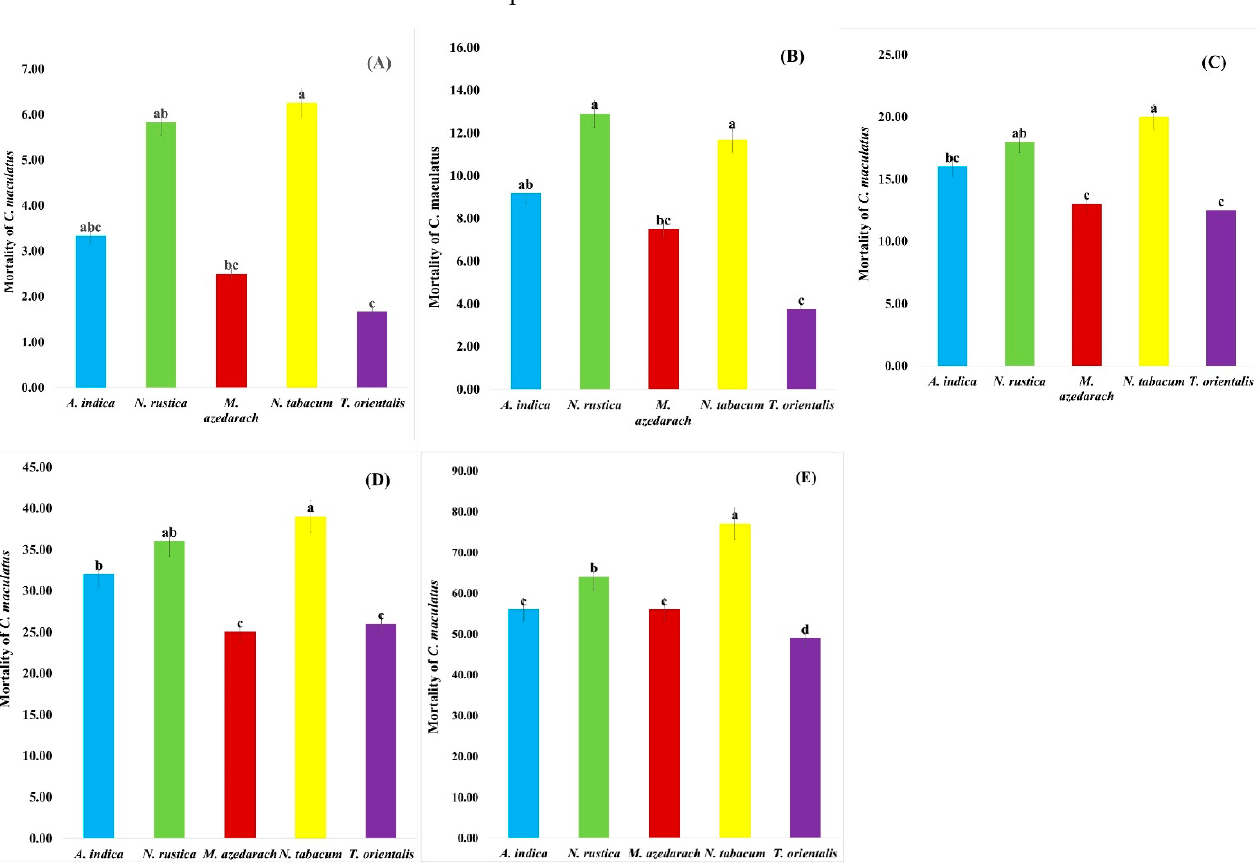
Figure 1. Mean percent Mortality of C. maculatus treated with plant extracts after ( A ) 24 h, ( B ) 48 h, ( C ) 72 h, ( D ) 168 h and ( E ) 336 h exposure (Residual effect). (a, b, c, d put over the bars indicating that different letters are significantly different from each other at 0.5% level of significance). Table 5 . Toxicological effect (Direct) of plant extracts against C. maculatus after 24, 48, 72, 168 and 336 hours’ exposure period.